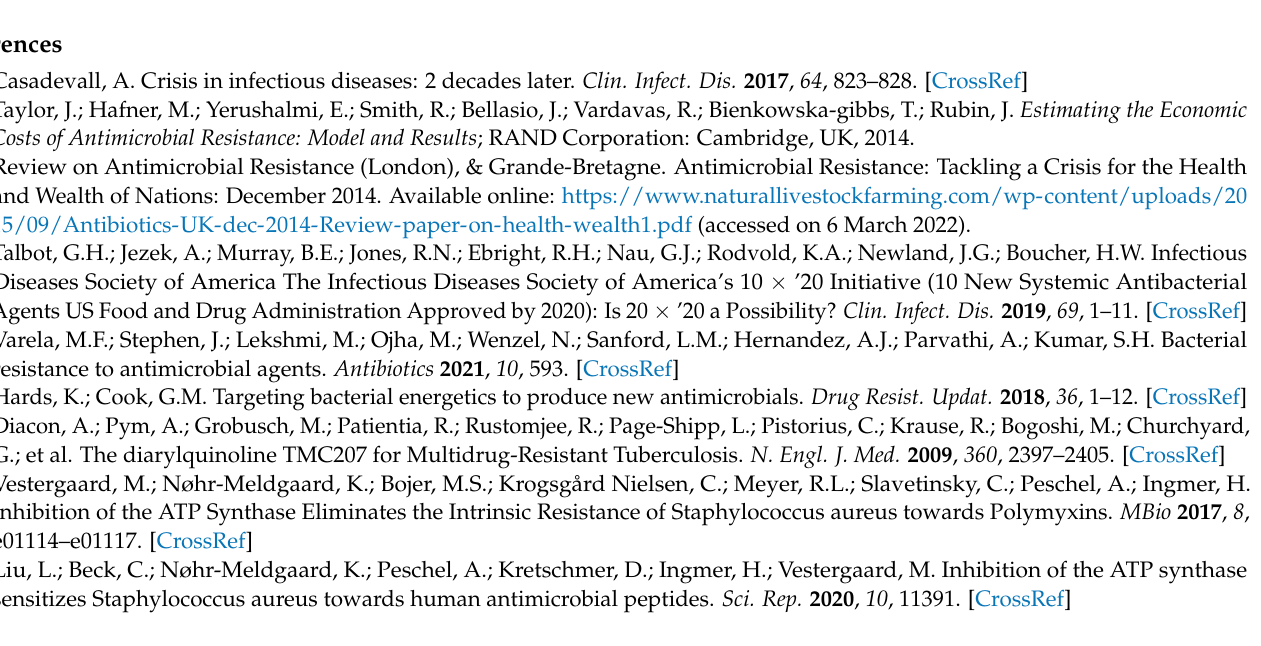
Figure S2: Conservation of the HTH motif in Mammalia class. Figure S3: Conserved contacts between residues of the HTH motif and neighboring subunits [112]. Figure S4: Conservation of the HTH motif in Bacilli class. [58,59,62,112] are cited in Supplementary